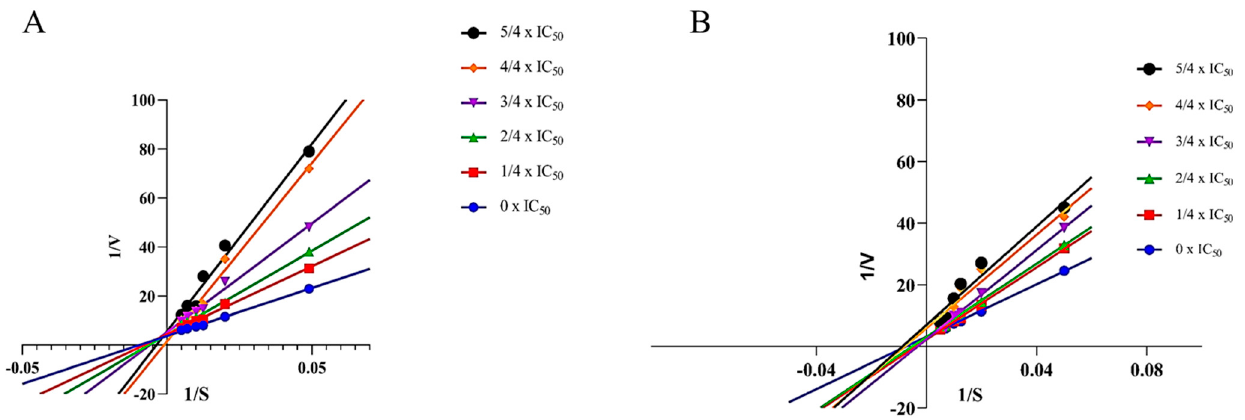
Figure 4. Kinetic inhibition using Lineweaver - Burk plots for MAO - B ligands 1 ( A ) and 2 ( B )